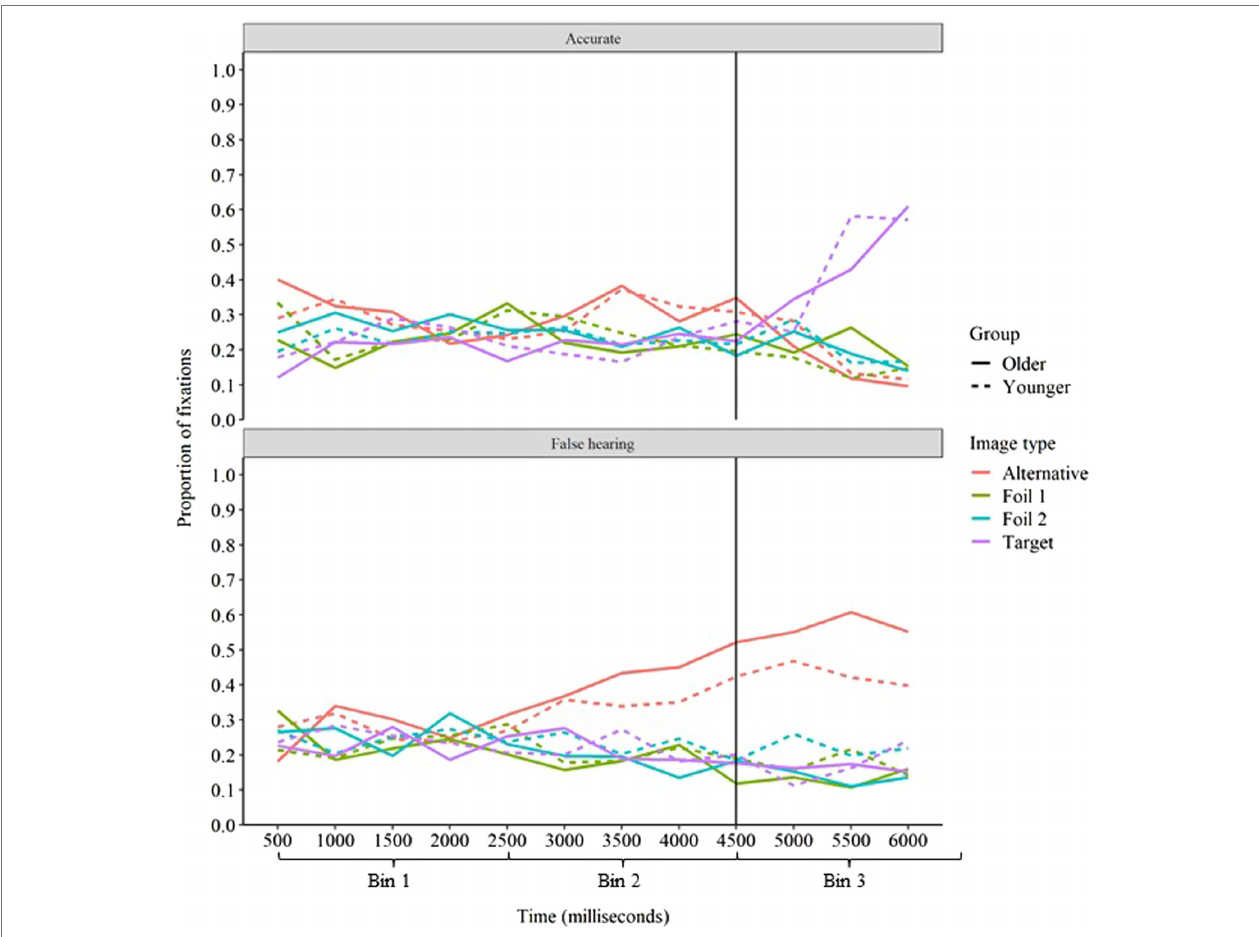
FIGURE 7 | Proportion of fixations on each image type over time in incongruent sentences for younger and older adults on accurate and false hearing. The vertical line at 4,500 ms represents the onset of the target